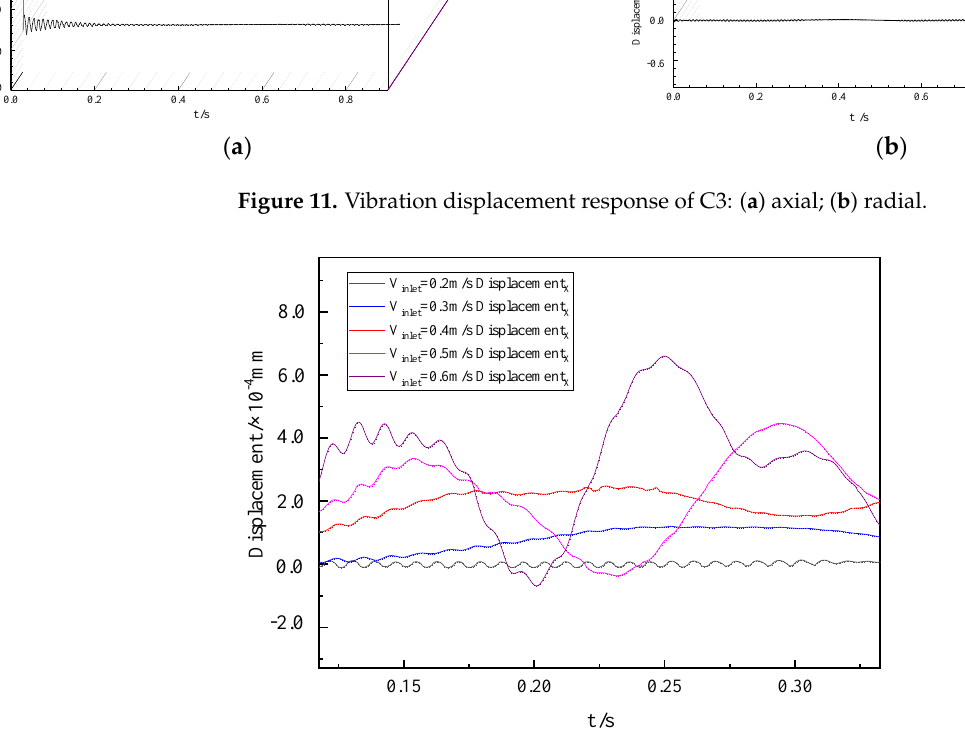
Figure 12. Partial radial vibration displacement response of C3.